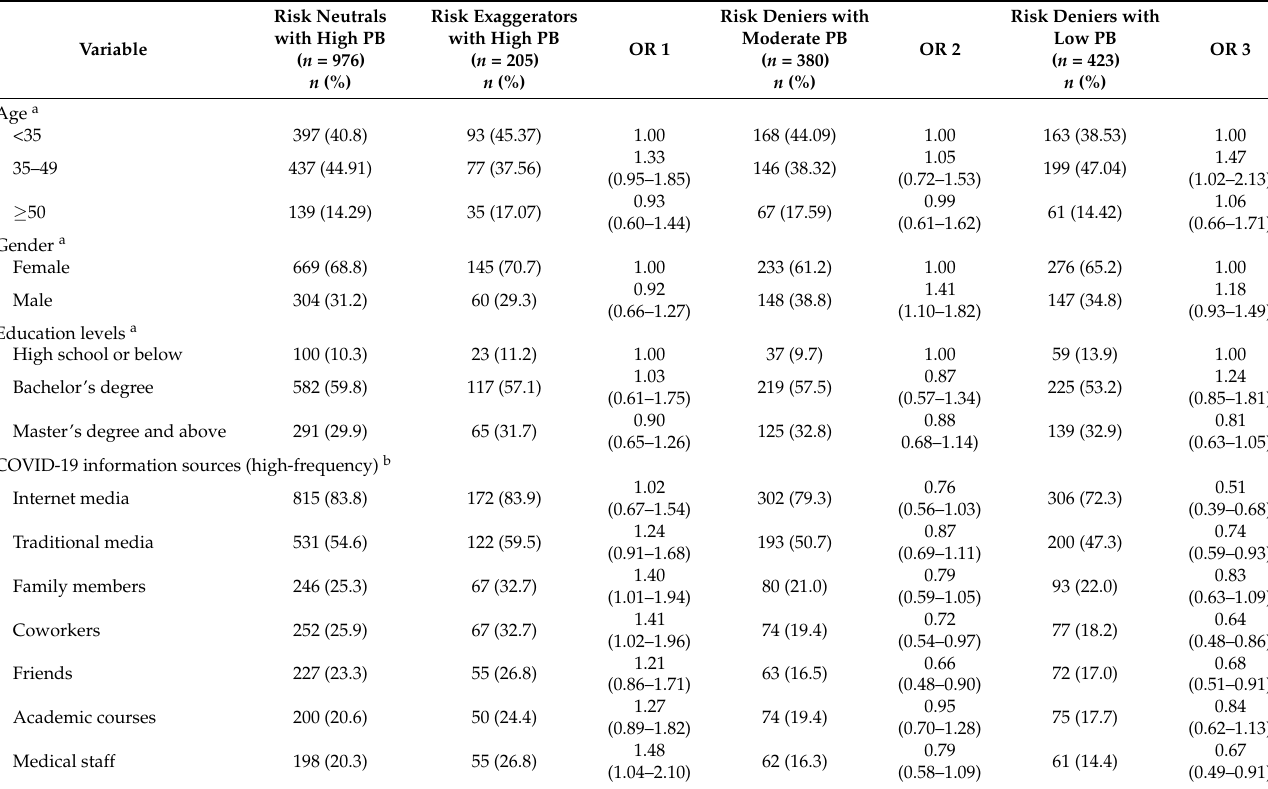
Table 3. Multiple multinomial logistic regression of risk perception and adoption of preventive behavior type on demo- graphics and information